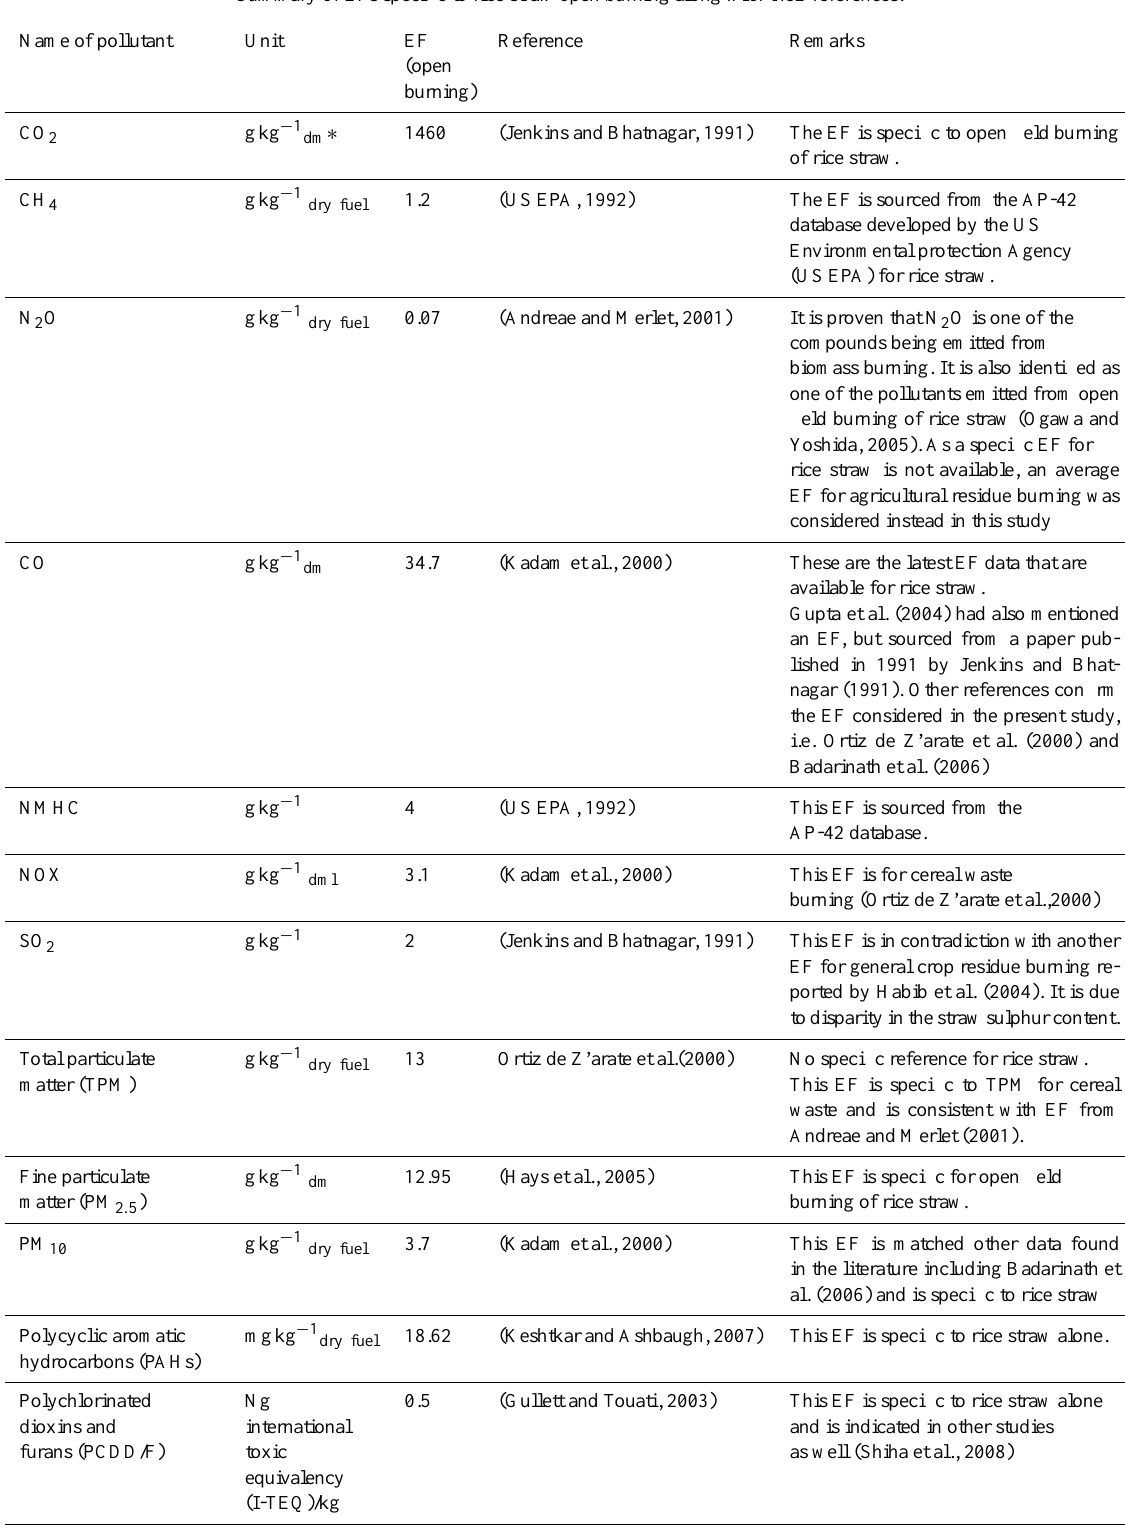
Table 2. Emission factors (EFs) (Gaddle et al., 2009). Summary of EFs specific to rice straw open burning along with their